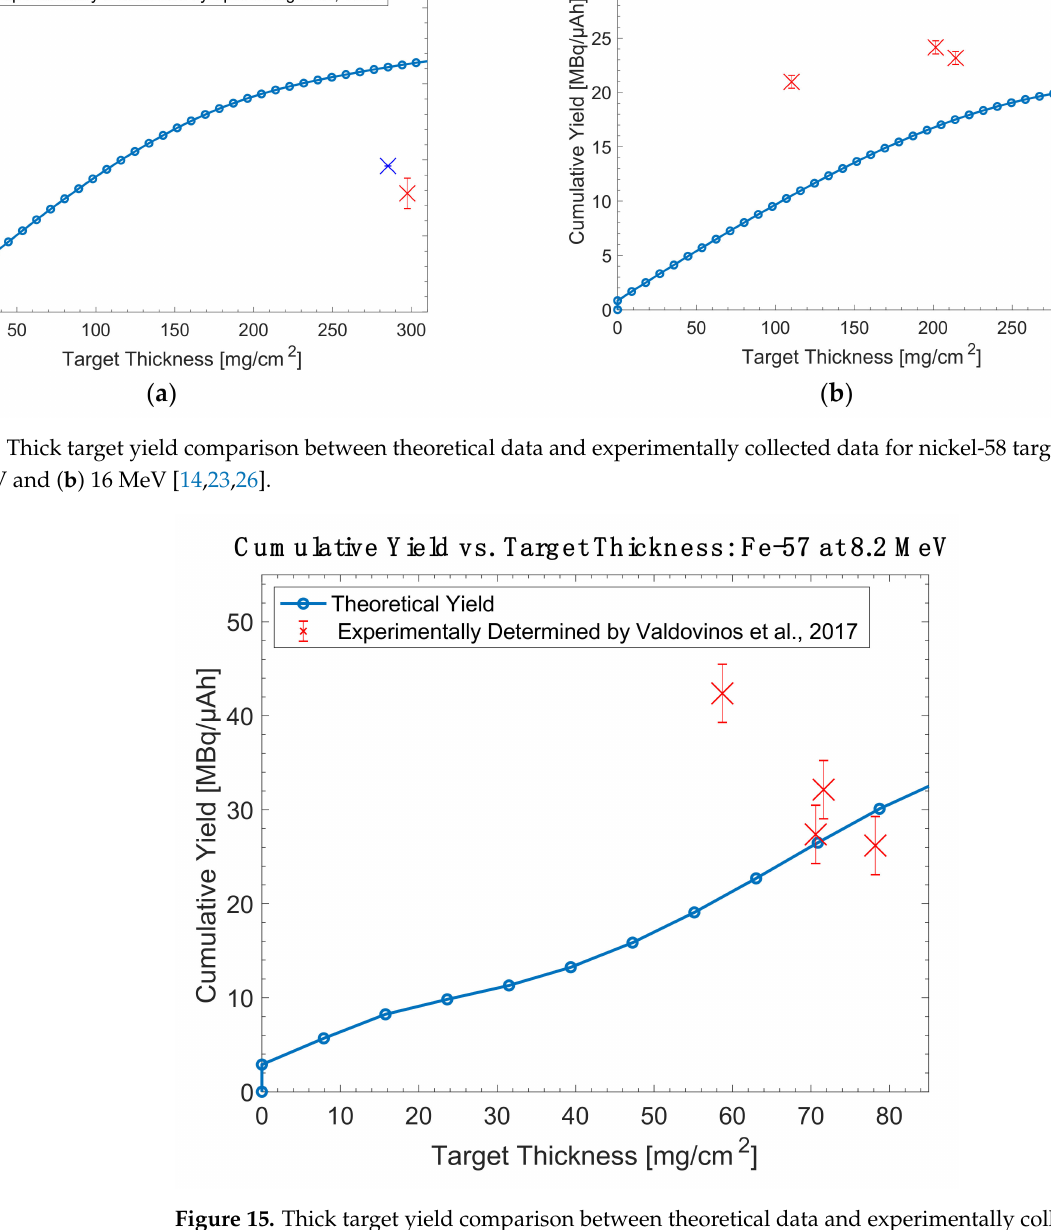
Figure 15. Thick target yield comparison between theoretical data and experimentally collected data for iron-57 targets at 8.2 MeV